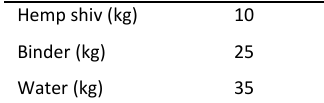
Table 1. Composition of the studied material. Hemp shiv